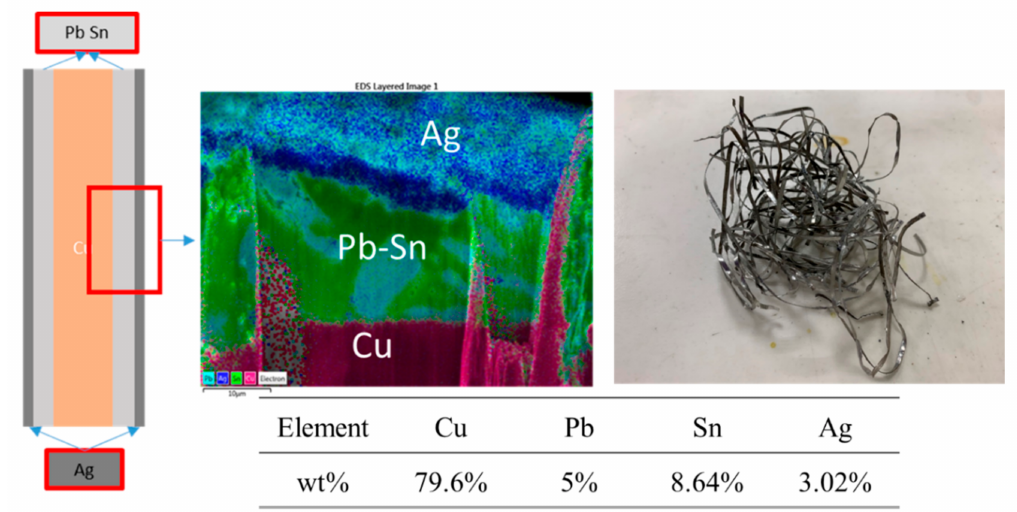
Figure 6. The SEM diagram and component of the PV